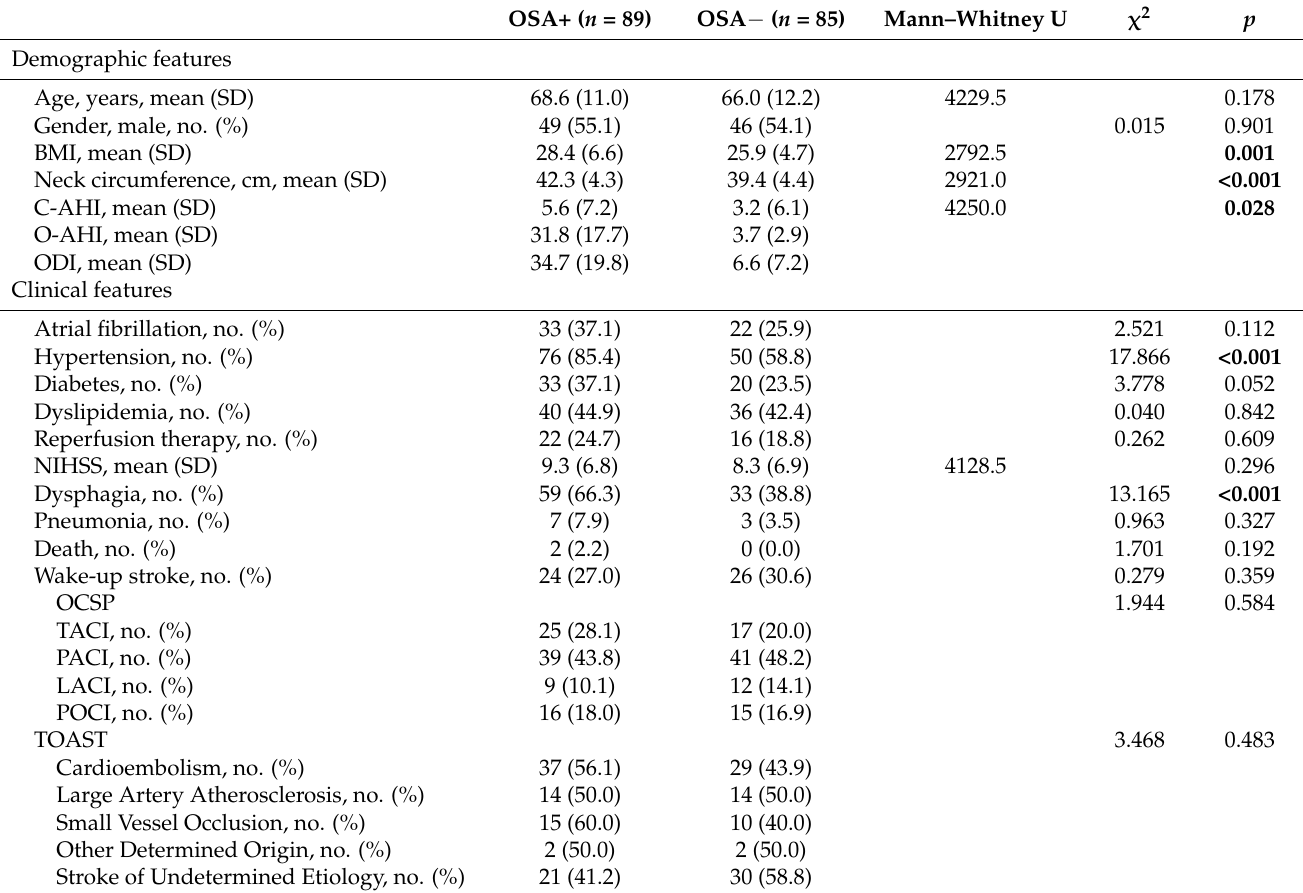
Table 2. Univariate comparison between OSA+ and OSA −